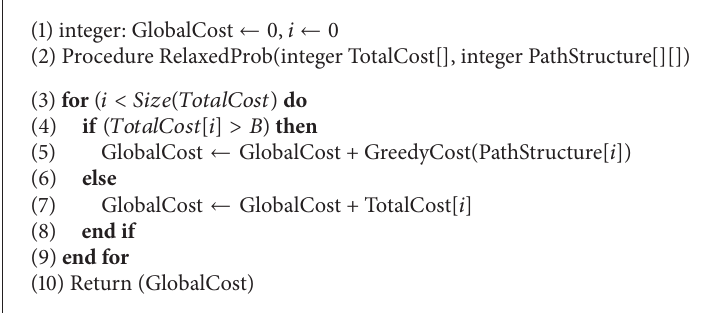
Algorithm 1: Greedy correction.